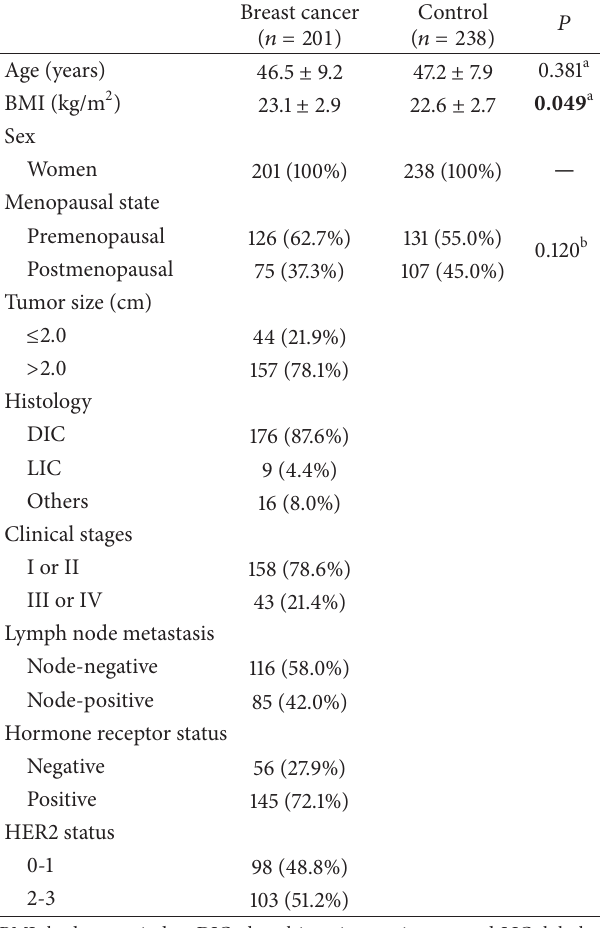
Table 1: Characteristics of breast cancer patients and control partic- ipants.